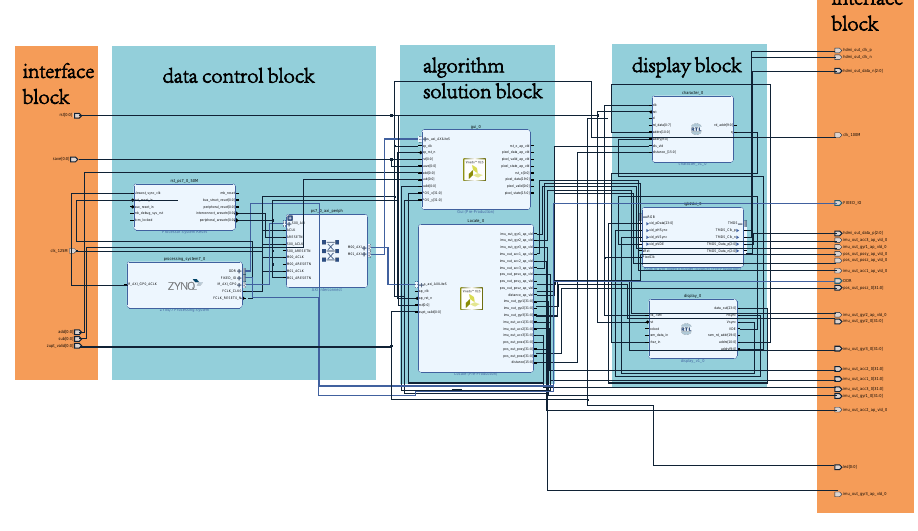
Figure 10. The whole block design of the